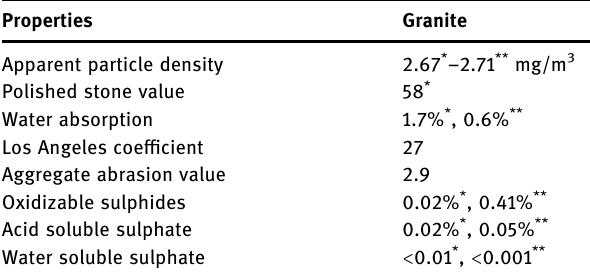
Table 3: Speci fi cations of aggregate Properties